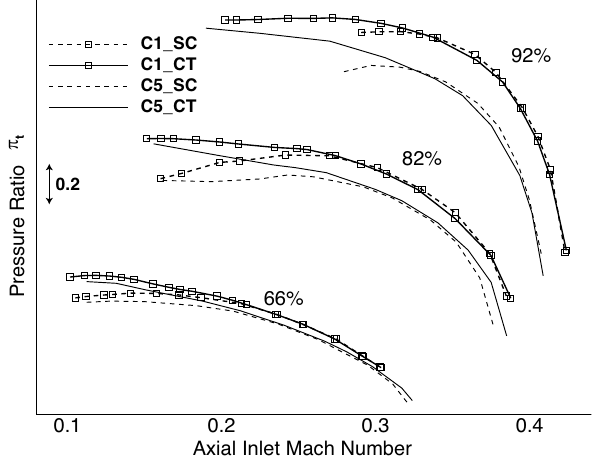
Figure 1. Compressor map enhancement with the developed CT in comparison to smooth casing (SC) for impeller C1 and a downscale version